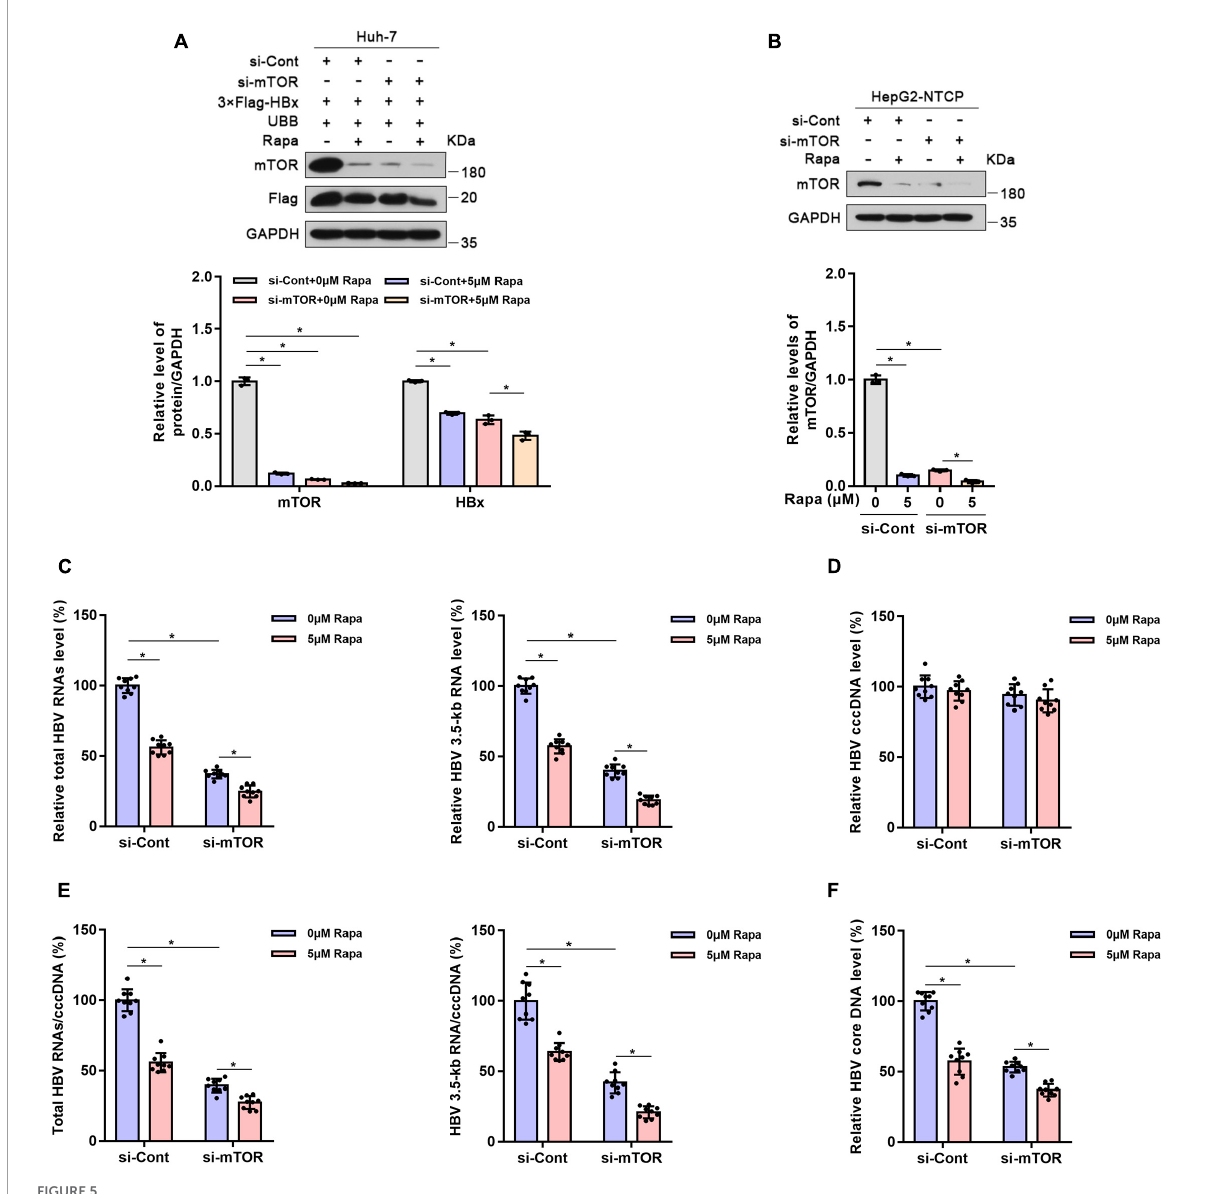
FIGURE5 Mechanistic target of rapamycin (mTOR) knockdown reduced HBV transcription and replication. Huh-7 cells were transfected with 3 × Flag-HBx and UBB plasmids and were then transfected with siRNAs for mTOR. Finally, the cells were treated with 5 µ M rapamycin for 24 h. HepG2-NTCP cells were transfected with siRNAs for mTOR, infected with 10 3 genome equivalents/cells of HBV, and then exposed to rapamycin for 6 days. (A,B) The levels of the different proteins in Huh-7 cells or HepG2-NTCP cells were examined by western blotting analysis, and GAPDH served as the loading control. (C) The levels of total HBV RNAs and 3.5-kb RNA were detected by real-time PCR using specific primers. The β -actin mRNA level was used as an internal control. (D,E) The level of cccDNA was analyzed by real-time PCR, and the ratios of HBV 3.5-kb RNA/cccDNA and total RNAs/cccDNA were calculated. (F) The level of HBV core DNA was analyzed by real-time PCR. The data are presented as the mean ± SD of three independent experiments. * P <